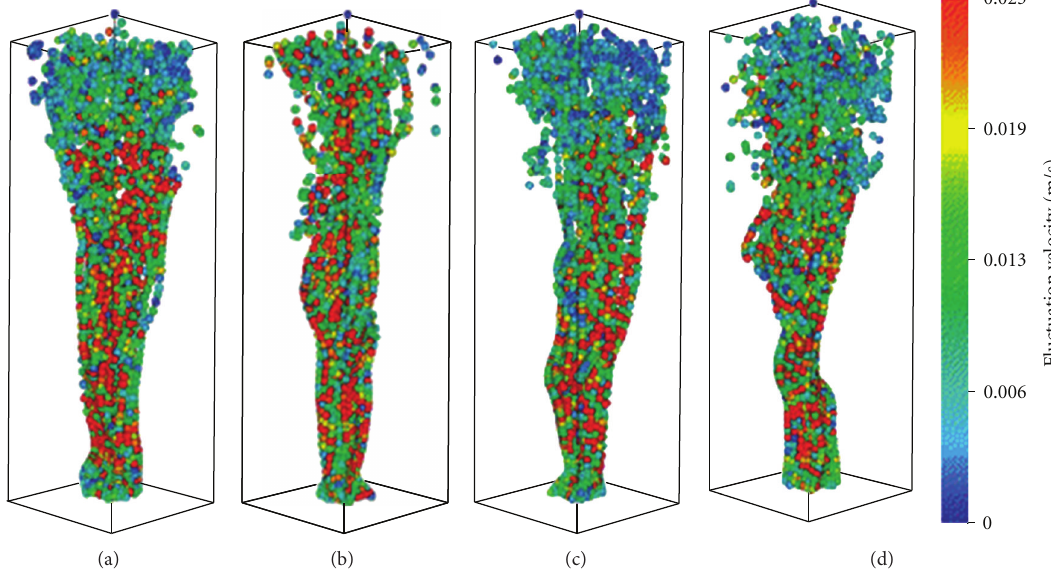
Figure 13: Snapshots of the bubble dispersion pattern after 20, 50, 100, and 150s. The bubbles are coloured by the local magnitude of the liquid fluctuations (from Sungkorn et al.